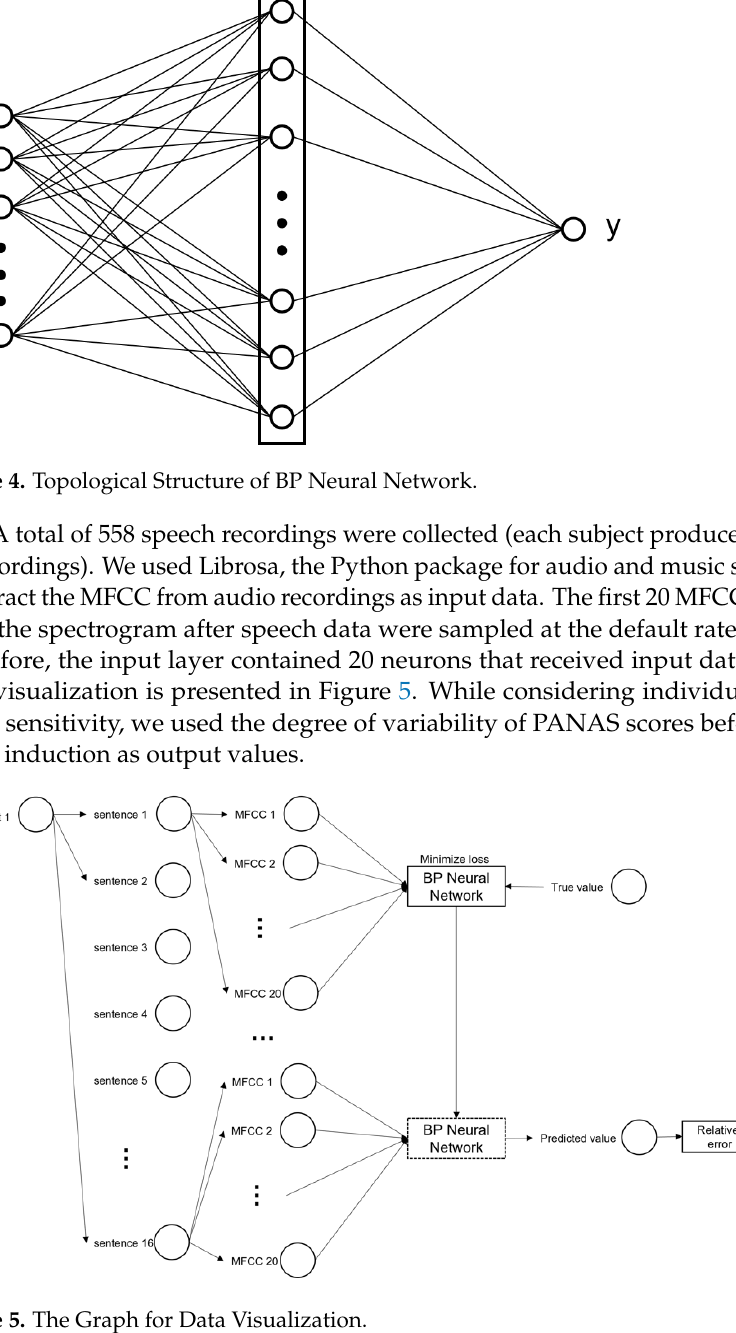
. Figure 6. Flow Chart of BP Neural Network Modelling. 3. Results 3.1. Verification of The Stress State Induction The results of the paired sample t-test for the subjective affect rating indicated a sig- nificant increase of negative emotion ratings after the stimulated nuclear power plant